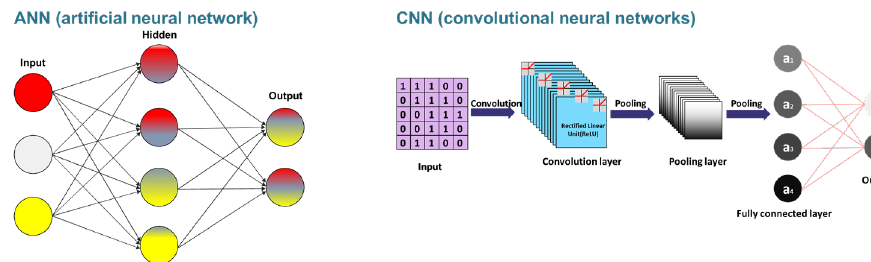
Figure 2. Conceptual diagram of ANN and CNN.